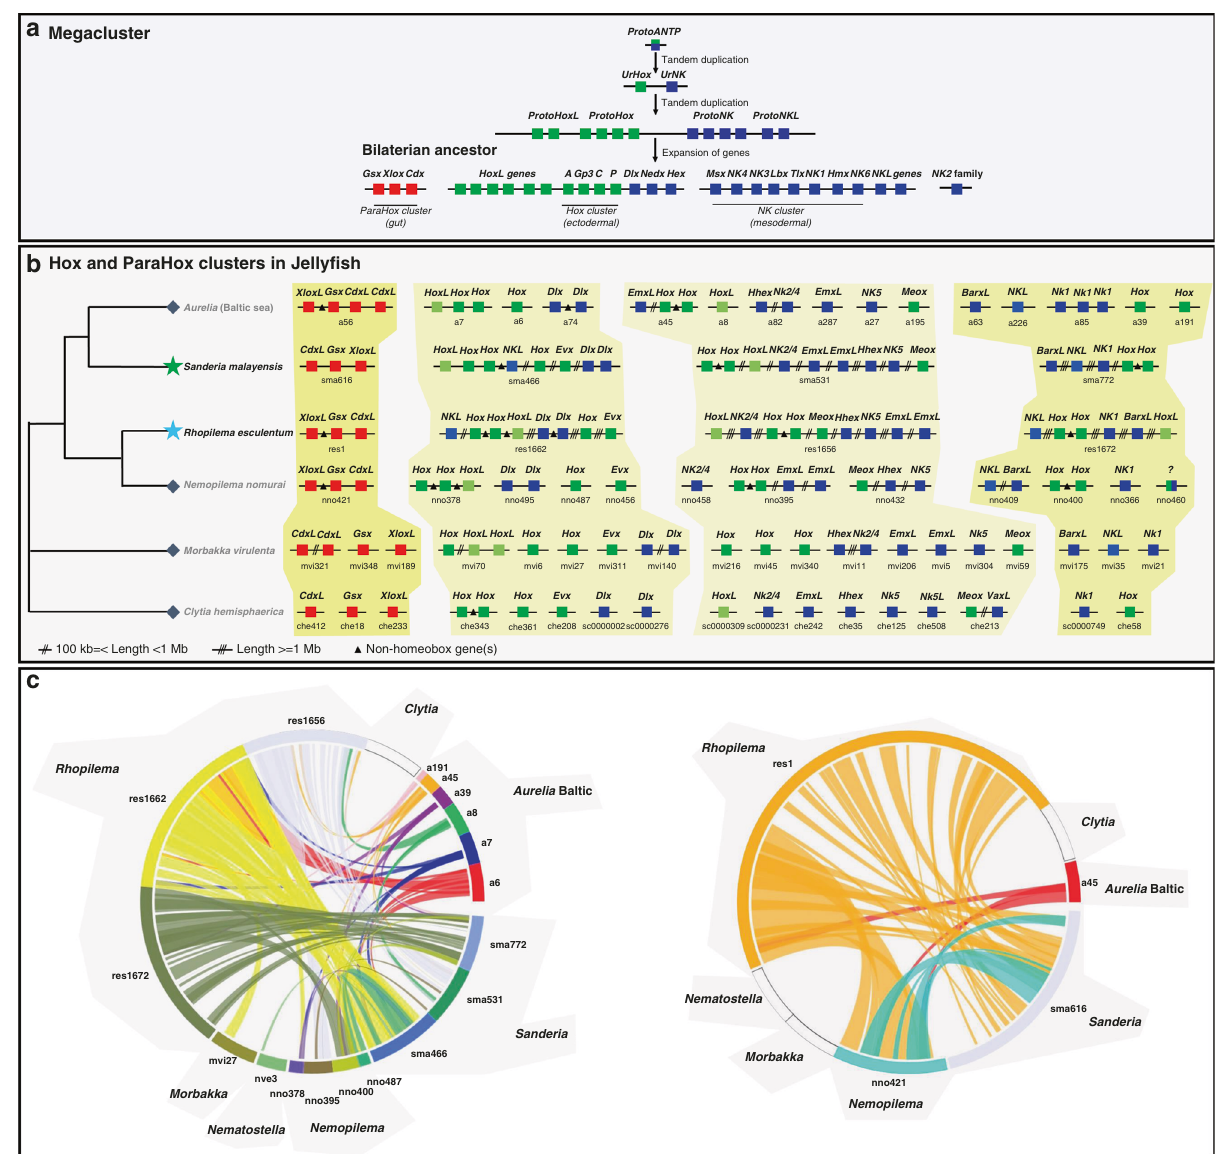
Fig. 2 Homeobox genomic organisation. a Schematic diagram showing origin of bilaterian homeobox gene clusters from a hypothesised ANTP class megacluster, with ParaHox cluster, Hox cluster, NK cluster, and NK2 genes located on separate chromosomes; b Schematic summary of ANTP-class homeobox gene arrangement in the jelly fi sh genomes; question mark denotes divergent ANTP-class homeobox genes; double slash denotes genomic distance >100 kb and <1 Mb; triple slash denotes genomic distance over 1 Mb; triangle denotes intervening non-homeobox gene and is only used when the distance <100 kb. A three gene ParaHox cluster is present in S. malayensis , and the interdigitation of Hox and NK cluster genes is recovered in Rhopilema esculentum and S. malayensis ; c Syntenic relationships between scaffolds containing Hox and ParaHox genes in cnidarians supporting gene